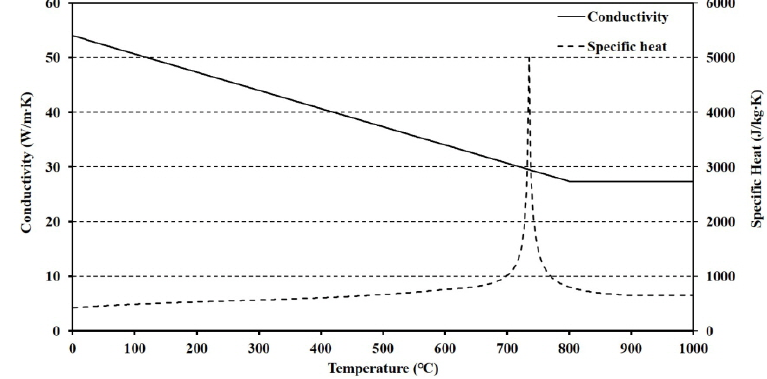
Figure 12. Conductivity and specific heat of steel at elevated temperatures.